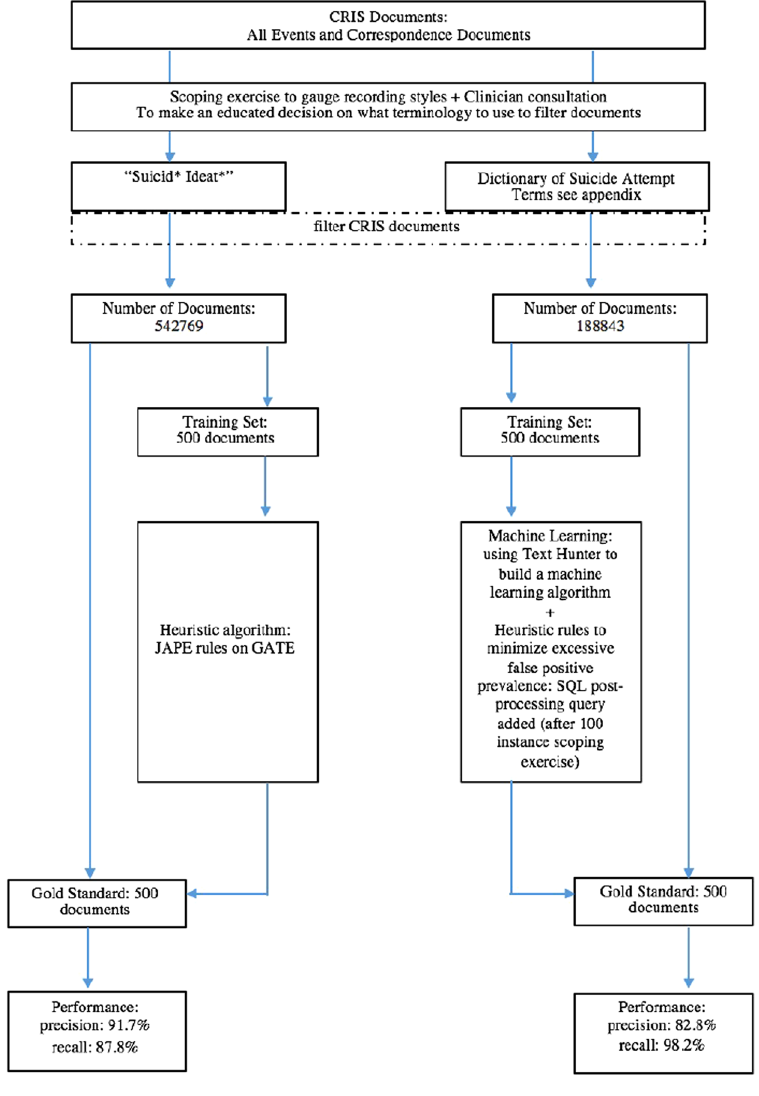
Figure 1. Schematic Outline of classification tool development and evaluation study. Event notes are free- text fields, where day-to-day notes can be recorded in any layout or format. Correspondence notes are used to attach any formal correspondences between patient and clinical staff or between clinical staff members. These documents constitute of letters and questionnaires recorded in word documents (which included any electronic questionnaires administered to the patient), pdf documents and any other documents related to the patient. “Suicid * ideat * ” is the text pattern used to filter variations of the phrase “suicidal ideation”, within each sentence in the clinical notes, where the asterisk denotes a wild card allowing for any combination of letters in the word after the initial specified sequence.